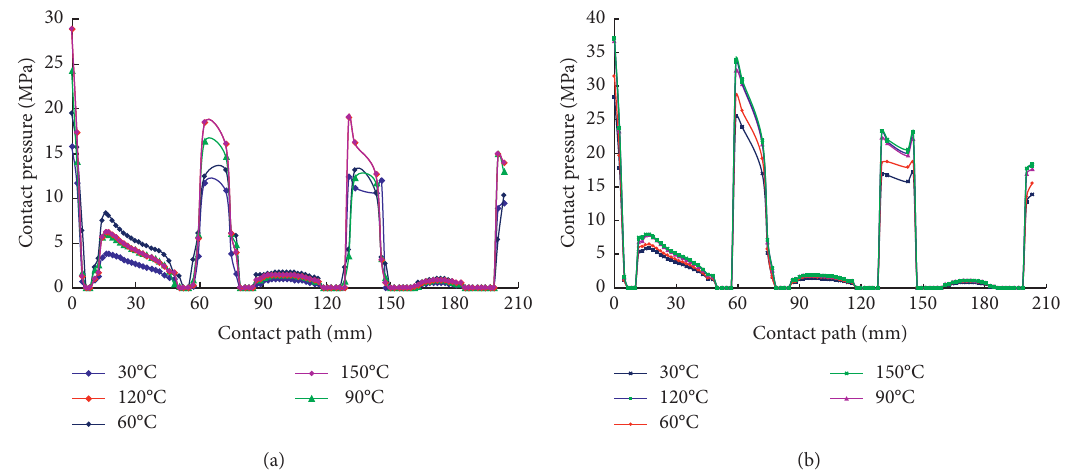
Figure 13: The contact pressure curves at different temperatures and hardness. (a) The hardness of the rubber cylinder is 70. (b) The hardness of the rubber cylinder is